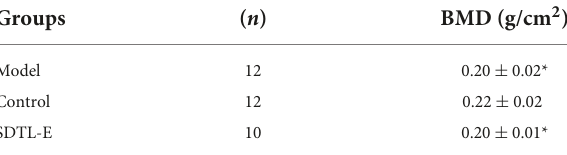
TABLE 1 BMD of rats 3 months after ovariectomy before treatment by bone densitometry analysis. Groups ( n ) BMD (g/cm 2 ) Model 12 0.20 ± 0.02* Control 12 0.22 ± 0.02 SDTL-E 10 0.20 ±